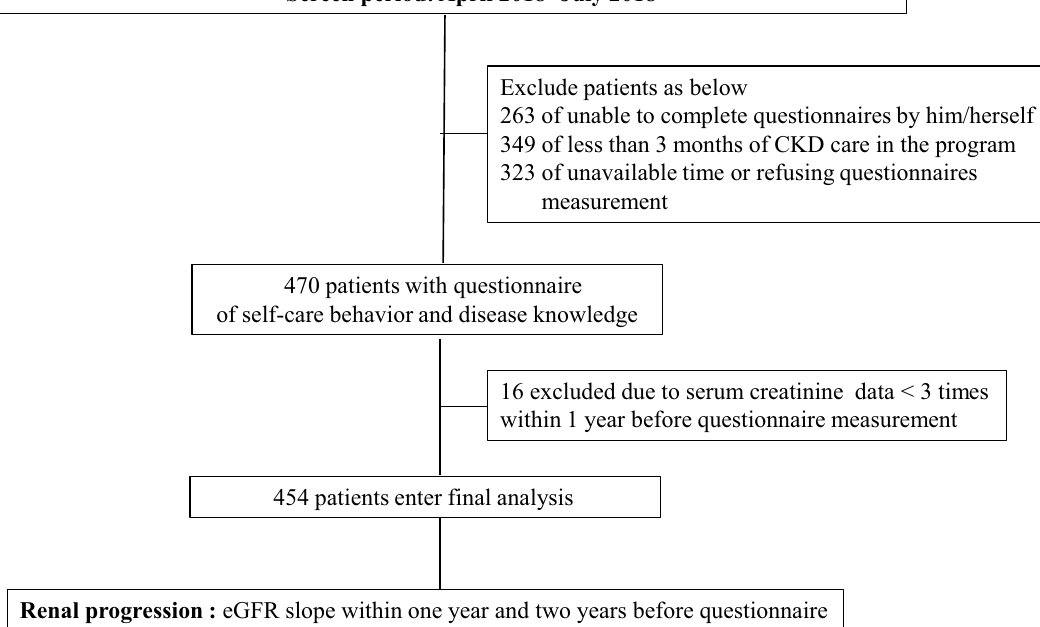
Figure 1. The flow chart of study subjects